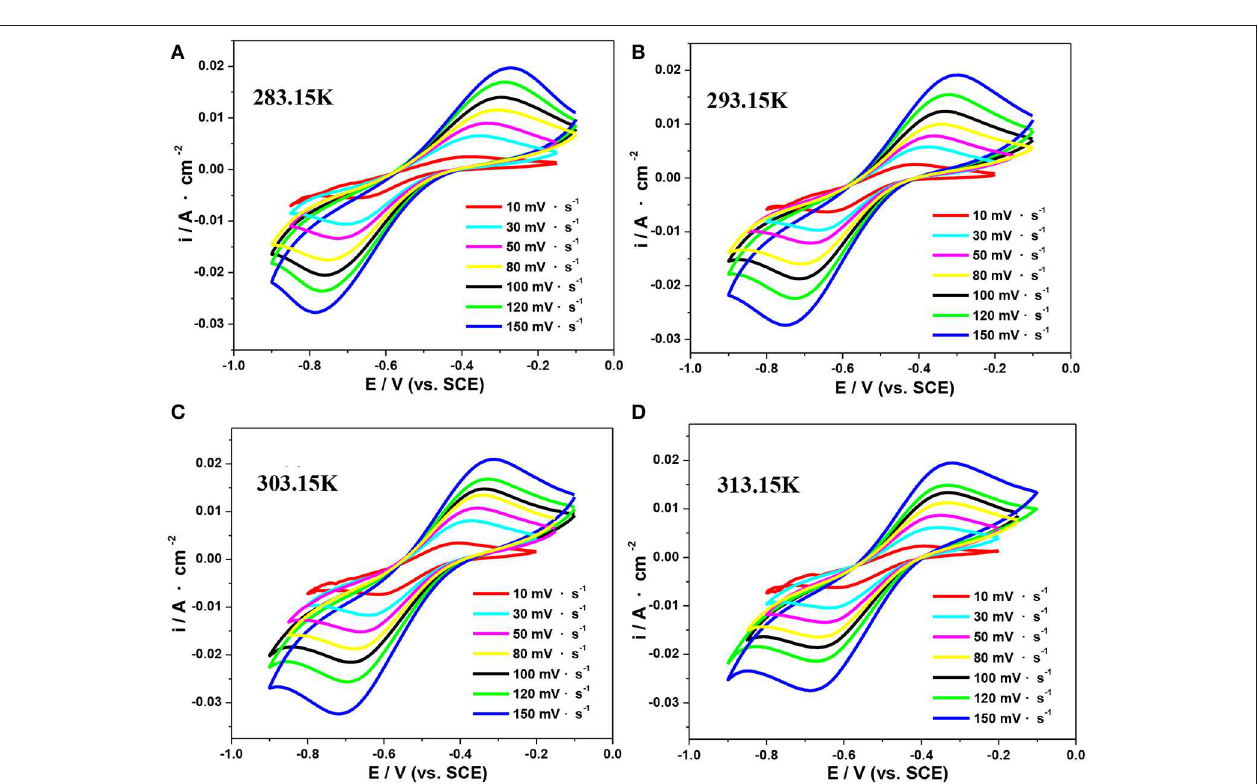
Frontiers in Chemistry |